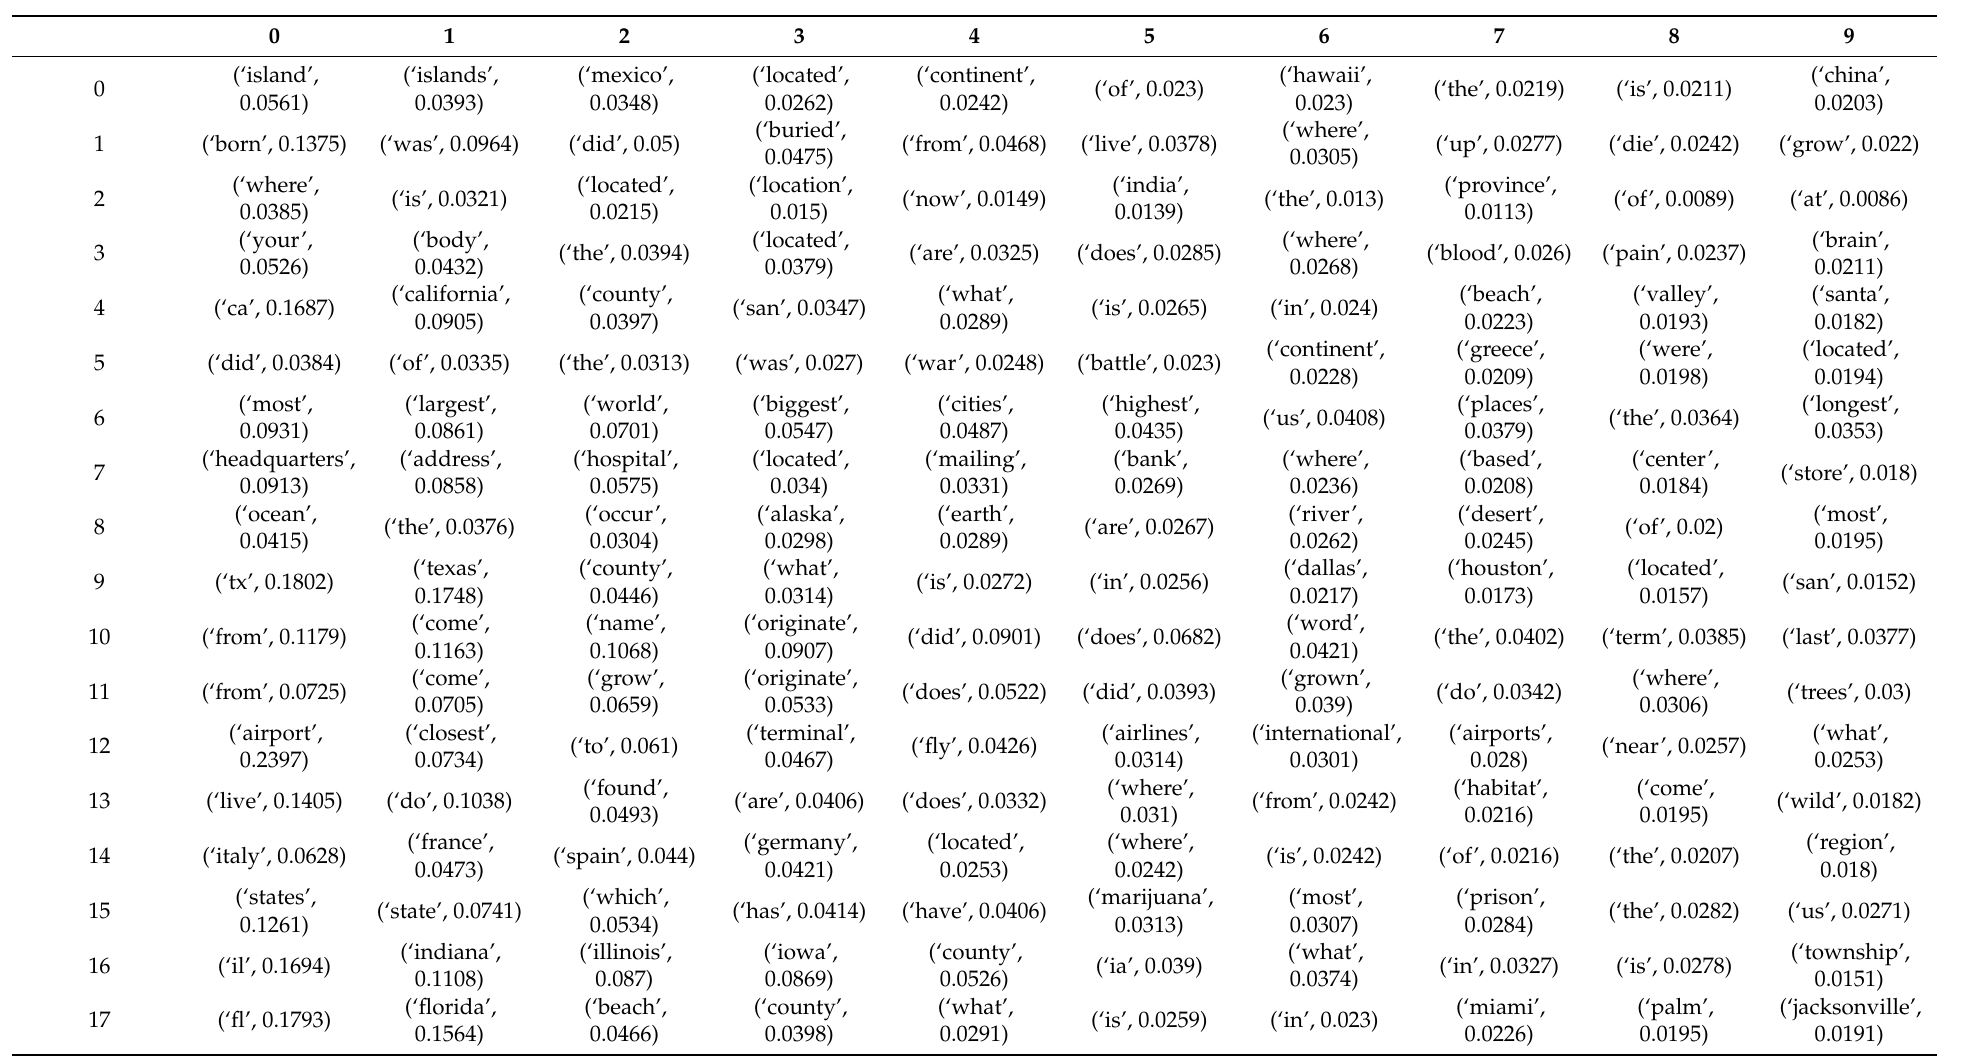
Table A2. Topic information. Each row represents the top 10 words in each